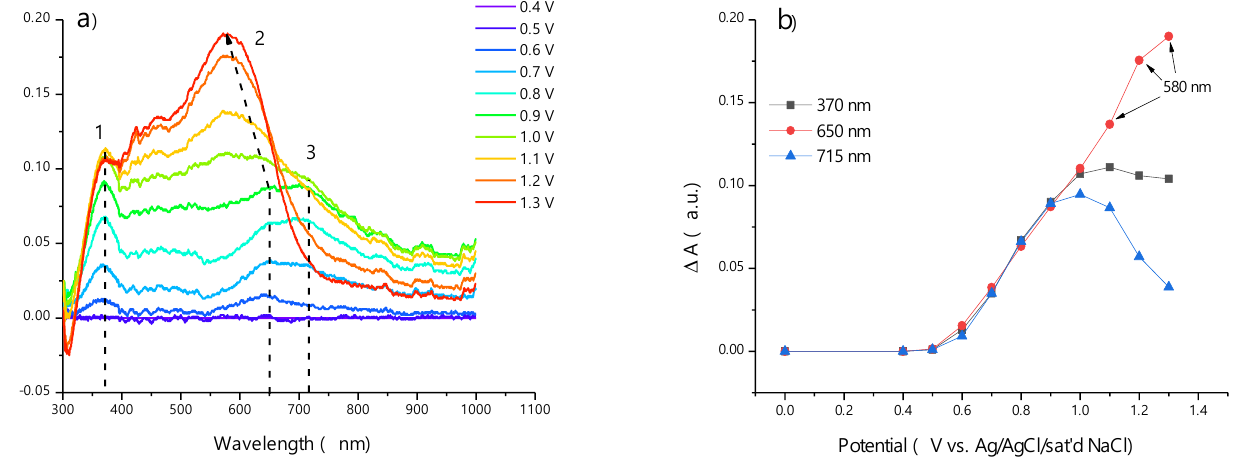
Figure 6. Evolution of in situ UV–VIS spectra during electrochemical oxidation of poly-H 2 (3-MeOSalen) in 0.1 mol dm −3 Et 4 NBF 4 /AN electrolyte, each UV–VIS spectrum was collected relative to that of the neutral (non-charged) polymer at the initial potential ( a ), and potential dependence of absorbance ( b ).